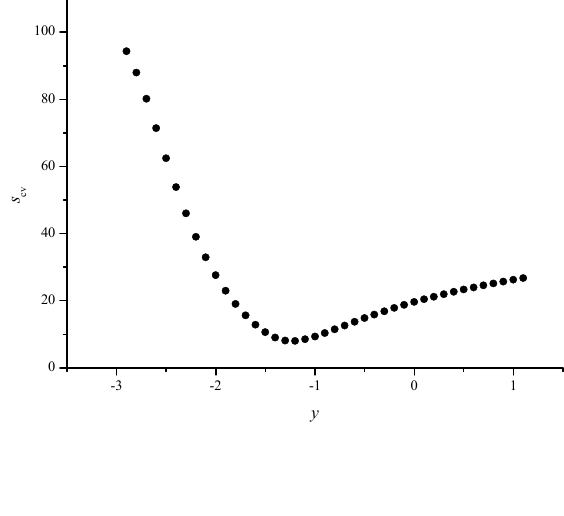
) and calculated values of the exp ) models, cv